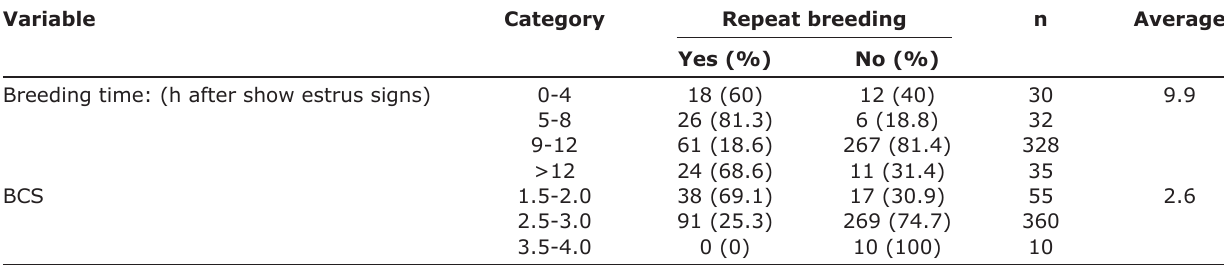
Table-3: Data distribution of repeat breeding risk factors for breeding time and body condition scoring of beef cattle in Sleman Regency,